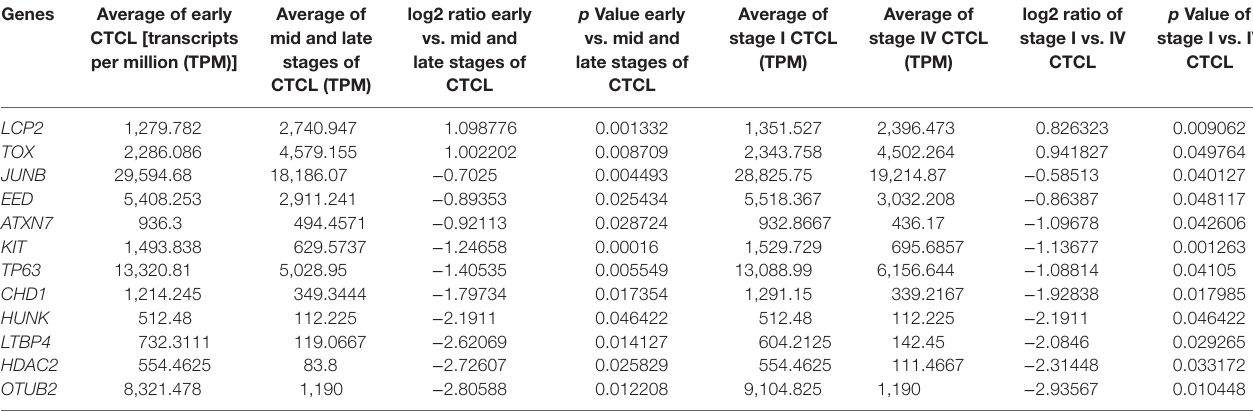
Average expression is presented as TPM. Positive log-2 ratios indicate upregulation in CTCL samples and negative log-2 ratios indicate downregulation in CTCL samples. p Values from Wald’s t-test are